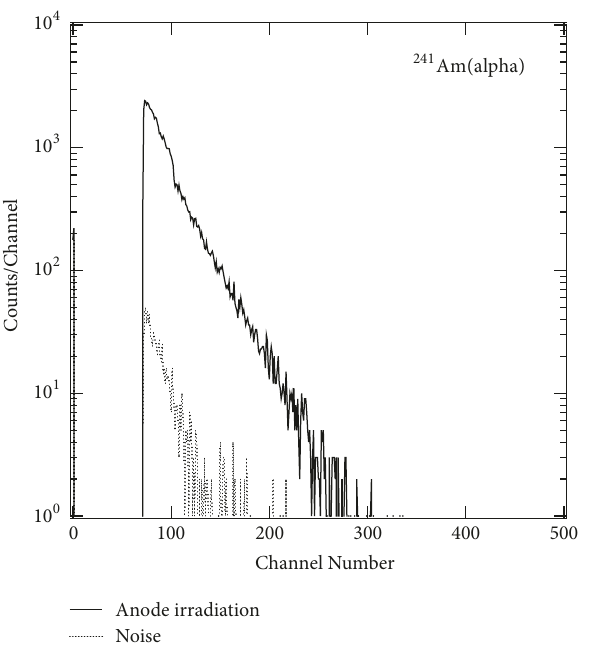
Figure 10: Alpha-particle energy spectrum obtained from the SbI 3 detector under cathode irradiation for 30 s and 180 s.